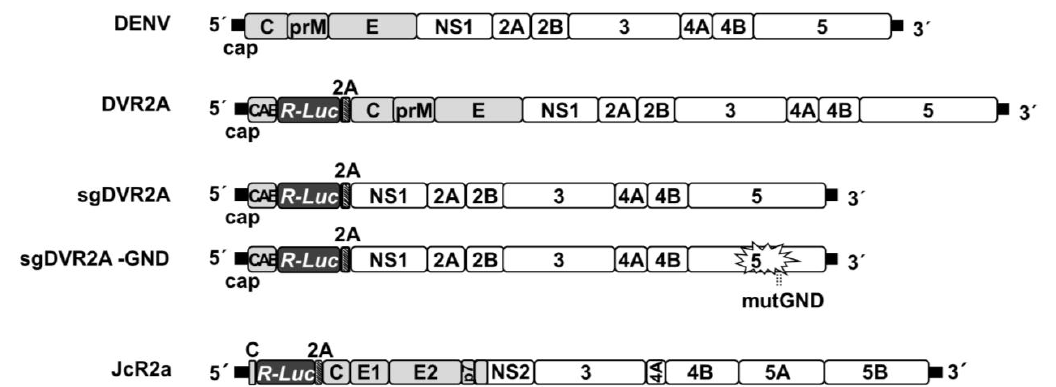
Figure 1. Schematic representation of virus constructs used in this study. From top to bottom: DENV2 full-length genome; DVR2A, derived from the DENV2 full-length genome by insertion of a Renilla luciferase (R-Luc) coding sequence downstream of the capsid cyclization sequence (CAE) and upstream of a Tosea asigna virus 2A protease cleavage site; sgDVR2A, a subgenomic reporter replicon derived from the DENV2 full-length genome by insertion of R-Luc coding sequence in-between CAE and the 2A cleavage site sequence. The last 24 amino acid residues of the envelope coding region (TM) at the N-terminus of NS1 ensure proper membrane topology of the polyprotein. sgDVR2A-GND, a replication-deficient NS5 mutant of sgDVR2A. All DENV constructs are derived from the DVs2 16681 isolate. JcR2a, a Jc1 (J6CF-JFH1 chimera) derivative containing the R-Luc gene fused N-terminally to 16 codons of the core gene (C) and C-terminally to the FMDV 2A protease cleavage site (grey striped box); Black bars in all panels indicate UTRs. Polyprotein cleavage products are labeled as specified in the introduction.